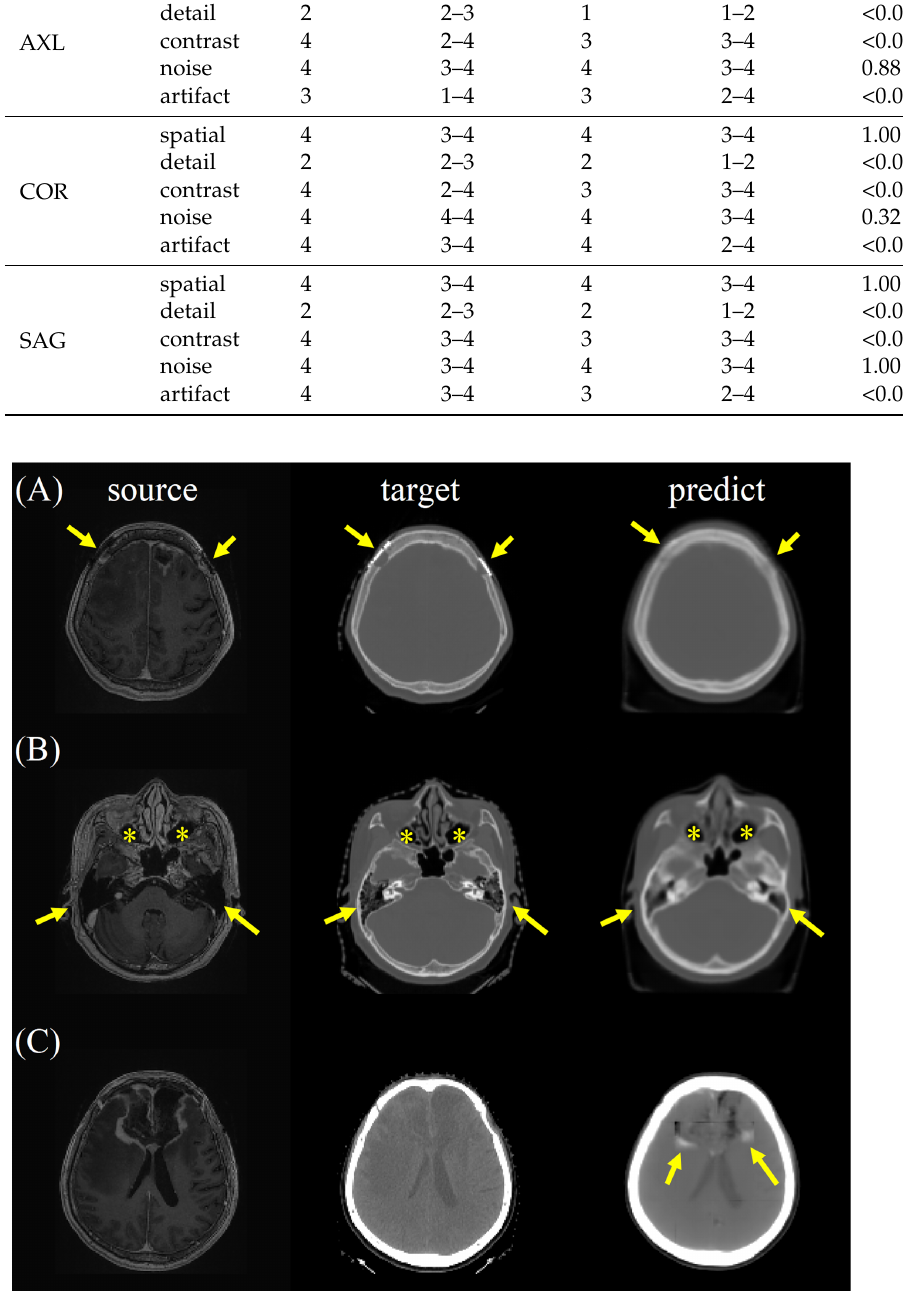
Figure 7. ( A ) The metallic artifact was reduced (arrows), and ( B ) the air density of the paranasal sinuses (asterisks) and mastoid air cells (arrows) were well preserved on the bone window images of the synthetic CT. ( C ) Perifocal hyperdensities (arrows) on the soft tissue window images of the synthetic CT might lead to a false impression of intracranial hemorrhage, which should have been postoperative encephalomalacia and white matter edema.